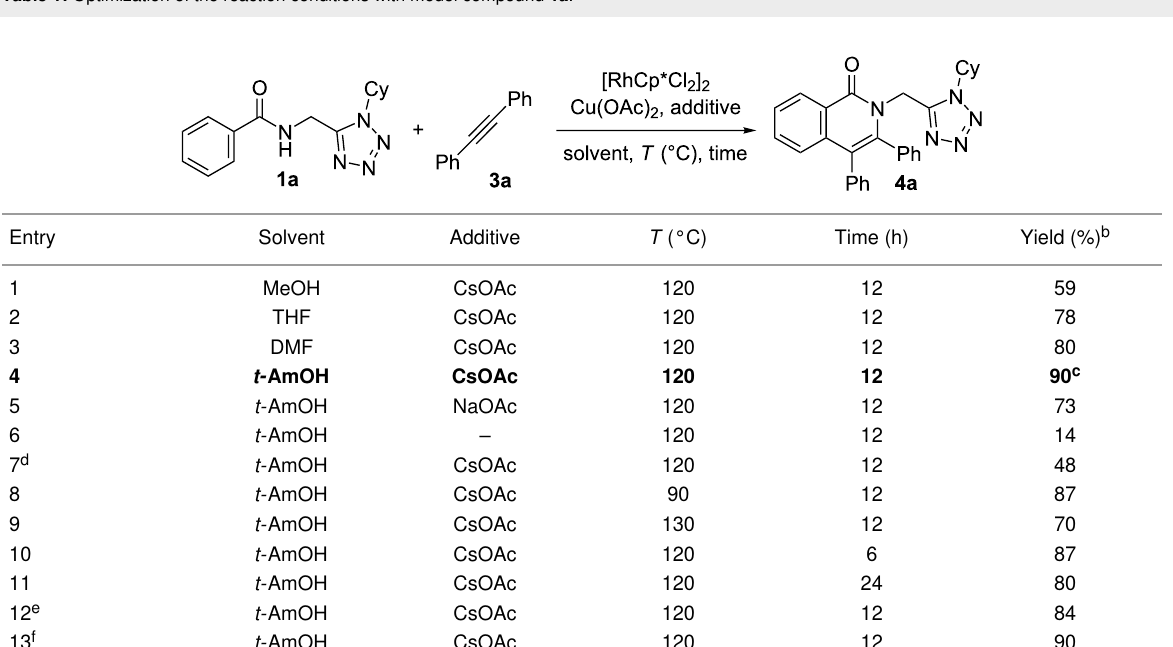
Table 1: Optimization of the reaction conditions with model compound 1a .